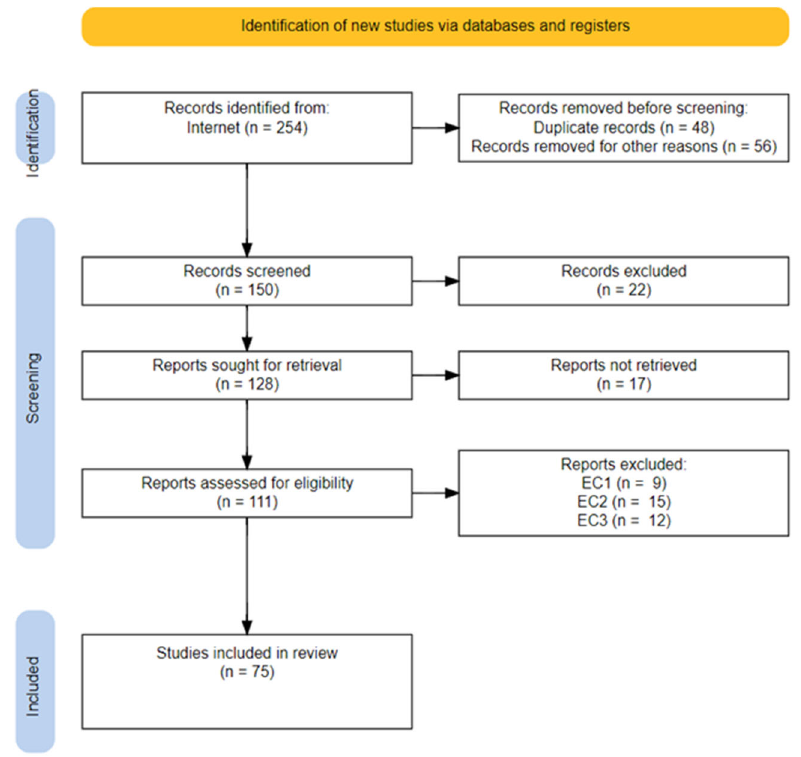
Figure 5. PRISMA flowchart of first primary question.